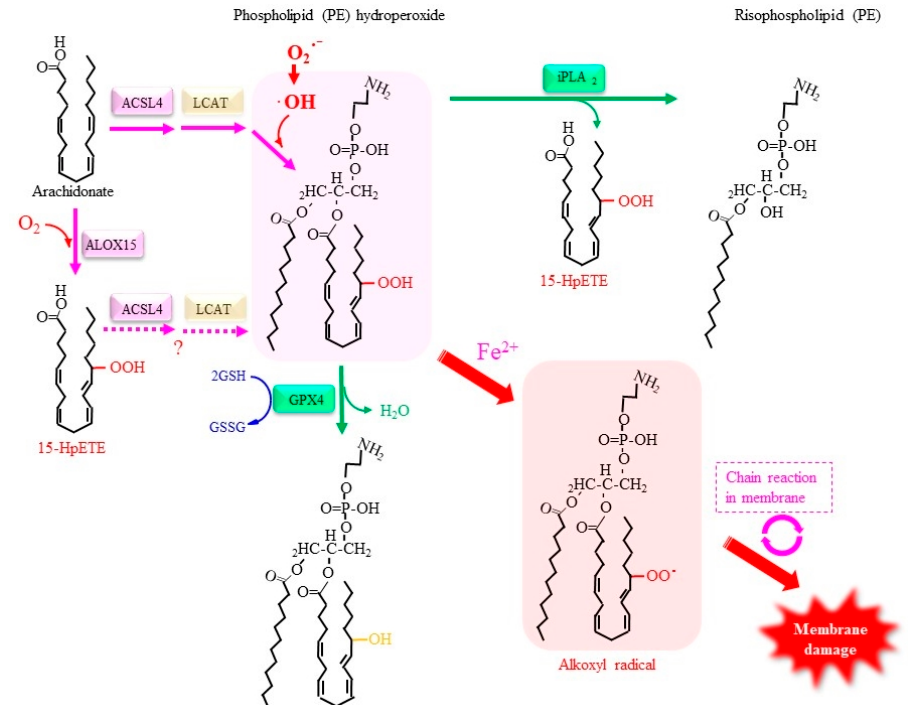
Figure 4. ALOX15 is a representative enzyme that catalyzes the peroxidation of arachidonate. ACSL4 preferentially acts on arachidonate derivatives and forms acyl-coenzyme A, which is then used to construct phospholipids by LCAT. Lipid peroxides in phospholipid bilayers react with free iron and result in the production of alkoxyl radicals, which enhances lipid peroxidation, ultimately leading to the destruction of the membrane structure. iPLA2 preferentially removes an acyl group at the sn-2 position where an unsaturated fatty acid is conjugated such that 15-HpETE can be excised by the action of iPLA2, which leads to the membrane structure being protected. Conversely, GPX4 interrupts the fatal chain reaction by reducing 15-HpETE to 15-HETE in the form of phospholipid hydroperoxide.